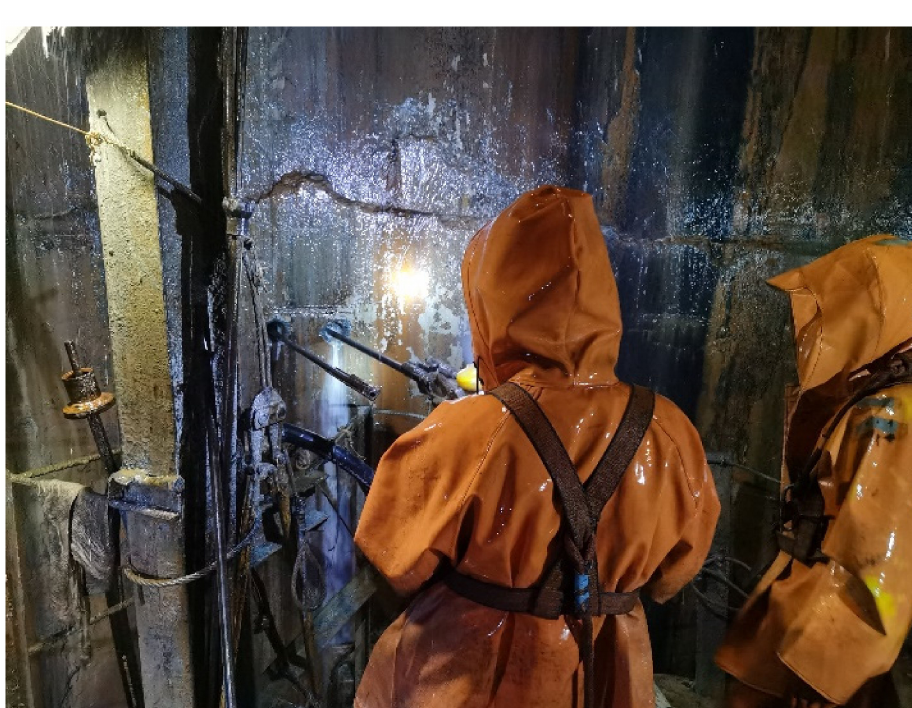
Figure 15. Field test